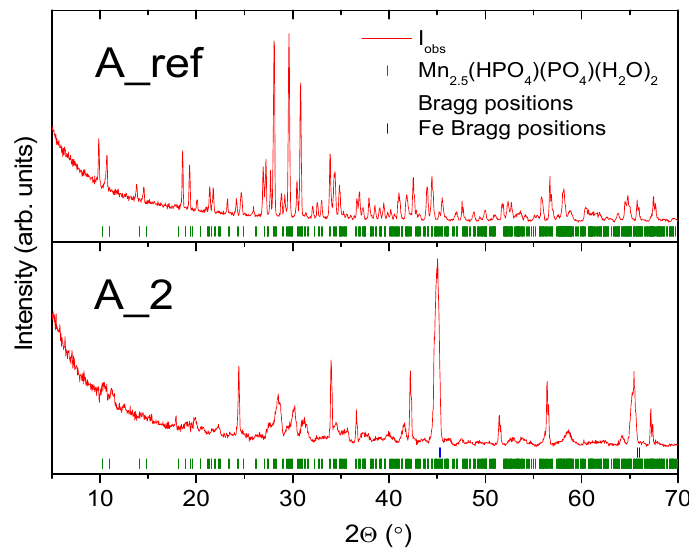
Figure 12. XRD patterns for the A_ref and A_2 samples. Solid red lines are measured patterns, the green tickmarks correspond to Mn 2.5 (HPO 4 )(PO 4 )(H 2 O) 2 phase, and the blue tickmarks correspond to iron.